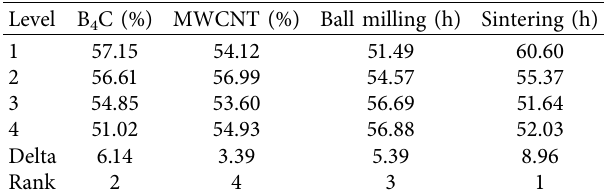
Table 11: Response table for signal-to-noise ratios (corrosion). Smaller is